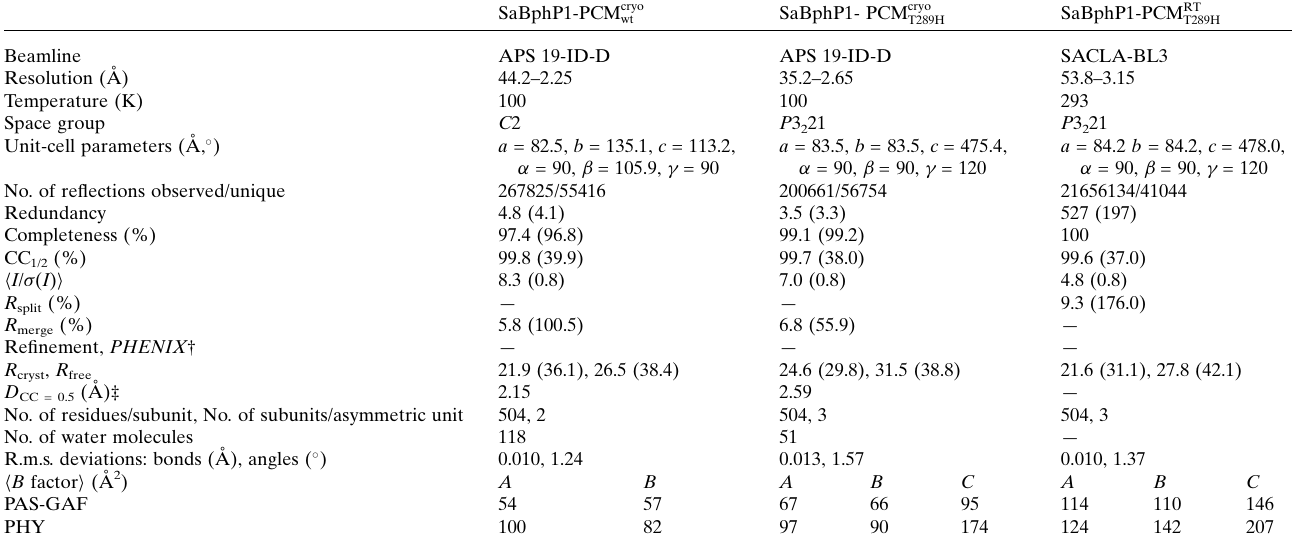
( b ) Structures of the SaBphP1 CBD wild-type and